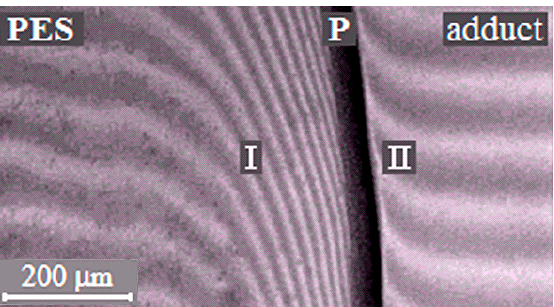
Figure 2. Typical interferograms of interdiffusion zones of the polysulfone (PSU)–epoxy oligomer (EO) systems ( a , b ) and polyethersulfone (PES)–EO ( c , d ) at 60 ( a , c ) and 220 °C ( b , d ). O is the optical boundary, IZ is the interdiffusion zone and P is the phase boundary.